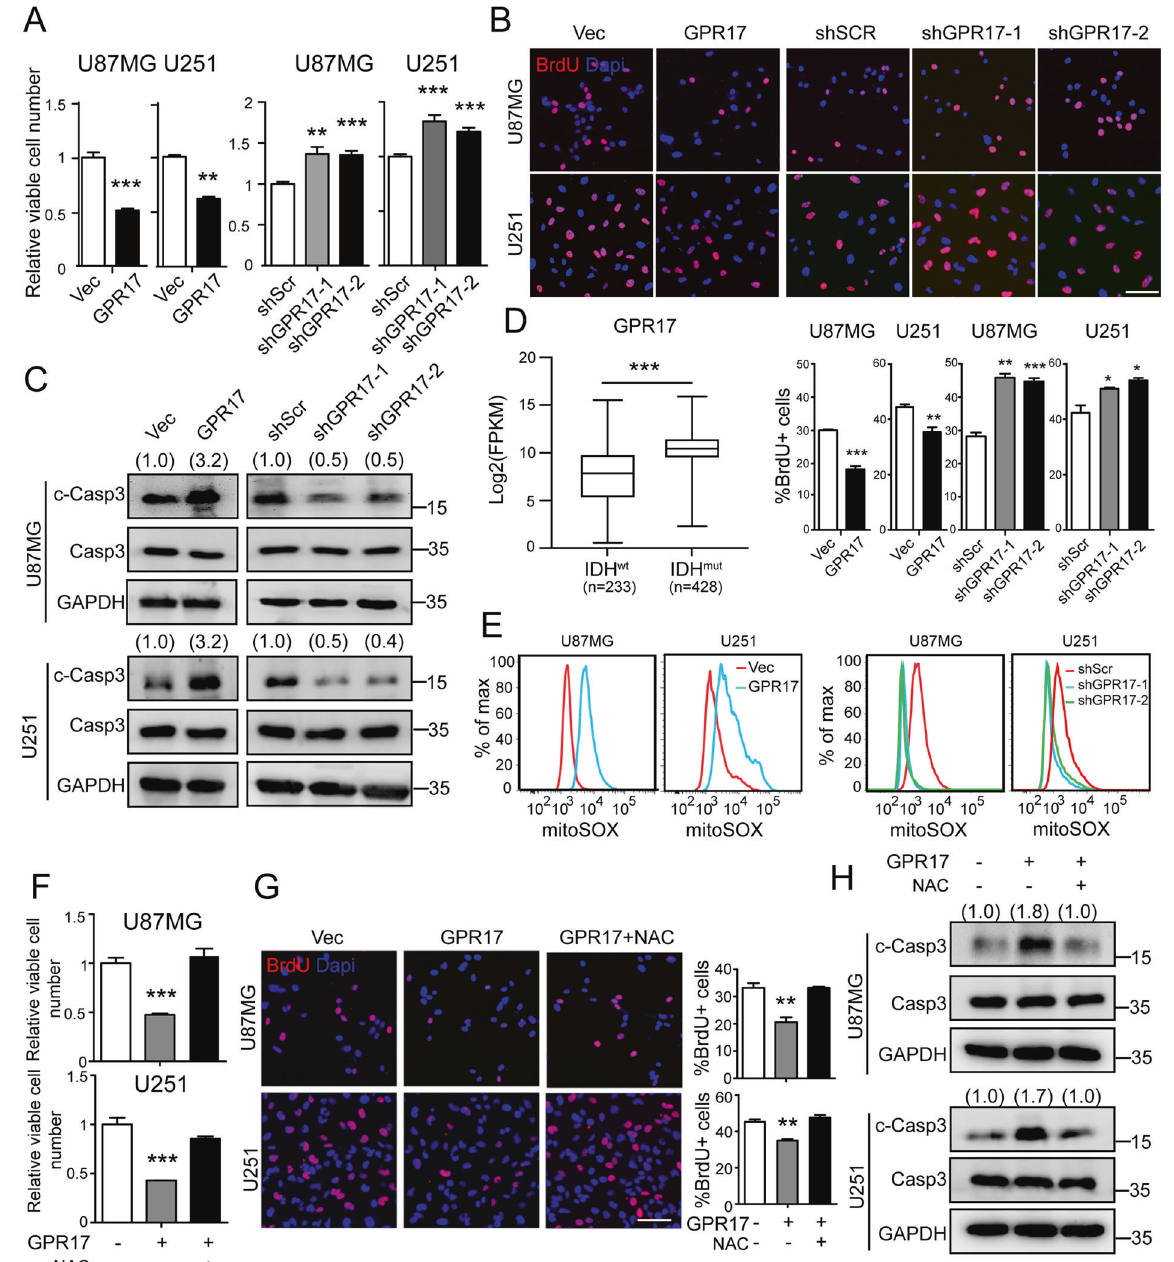
Fig. 2 GPR17 inhibited cell proliferation and induced cell death by inducing ROS level. GPR17-overexpressing/knockdown U87MG or U251 stable cell lines (U87/U251-GPR17 or U87/U251-shGPR17) were generated as described in “ Materials and methods ” . After con fi rming the overexpression or knockdown ef fi ciencies of GPR17, cells were cultured and harvested for the subsequent experiments. A CCK-8 assay was performed to examine viable cell numbers. B Immuno fl uorescent staining against BrdU was performed to examine the numbers of proliferating cells, scale bar, 400 μ m. The proportions of the BrdU + cell in the total cell number were displayed in the lower panel. C Western blot was performed to examine intracellular cleaved-caspase3 levels. Densitometric quanti fi cation of cleaved-caspase3/caspase3 ratio from at least three independent assays was indicated on top of each band, respectively. D Expression of GPR17 in IDH wt ( n = 233) and IDH mut ( n = 428) glioma patients from the TCGA cohort. E Flow cytometry analysis was performed to assess mitochondrial ROS level. F – H Control and U87/ U251-GPR17 cells were treated with vehicle or N -acetyl- L -cysteine (5 mM) for 48 h, CCK-8 assays ( F ), immuno fl uorescent staining against BrdU ( G ), and western blotting against cleaved-caspase3 ( H ) were performed as mentioned above. Scale bar, 400 μ m. Densitometric quanti fi cation of cleaved-caspase3/caspase3 ratio from at least three independent assays was indicated on top of each band, respectively. For all panels, data represent the means ± SEM from three independent experiments. * p < 0.05, ** p < 0.01, *** p < 0.001, Student ’ s t